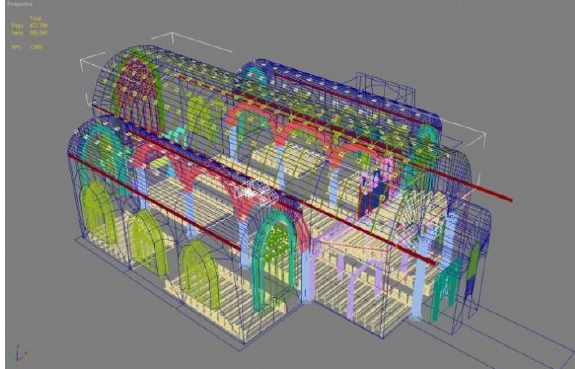
Figure 10 A wireframe model of the reconstructed church.